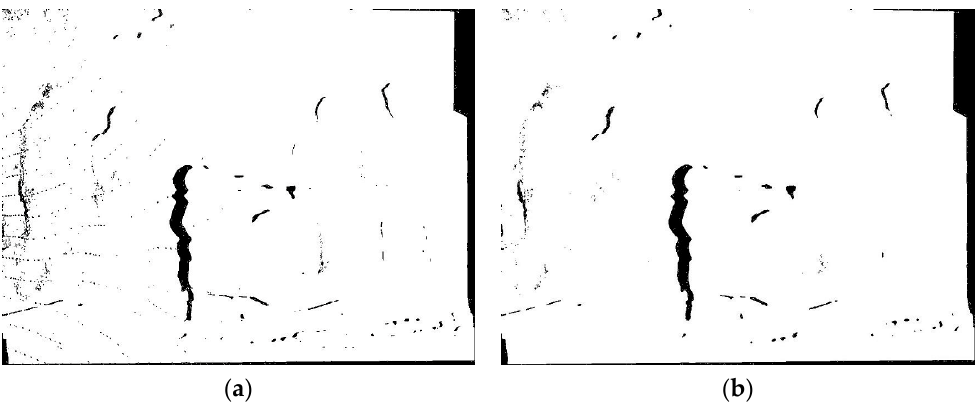
Figure 8. Filtering results. ( a ) Filtering the entire depth map, ( b ) filtering the holes .